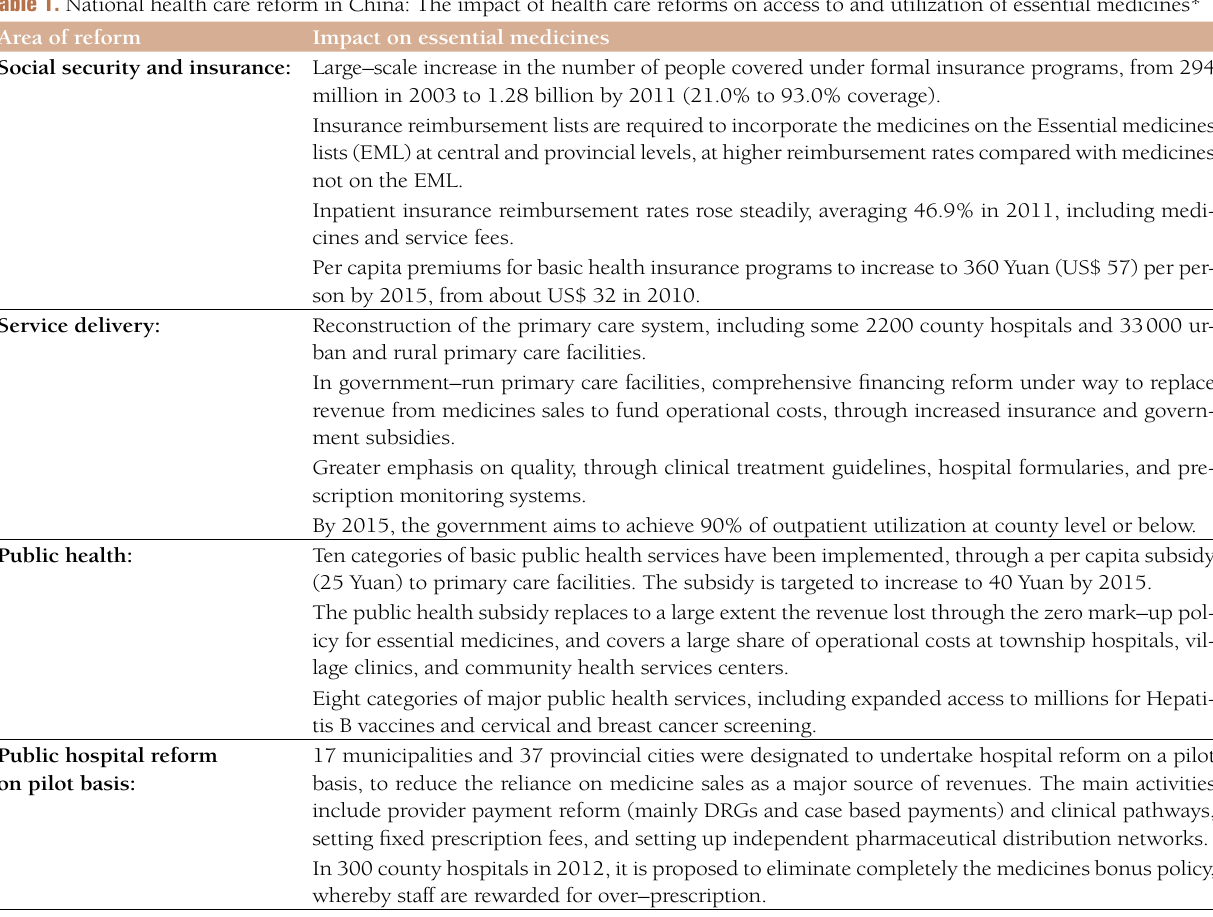
Table 1. National health care reform in China: The impact of health care reforms on access to and utilization of essential medicines* Area of reform